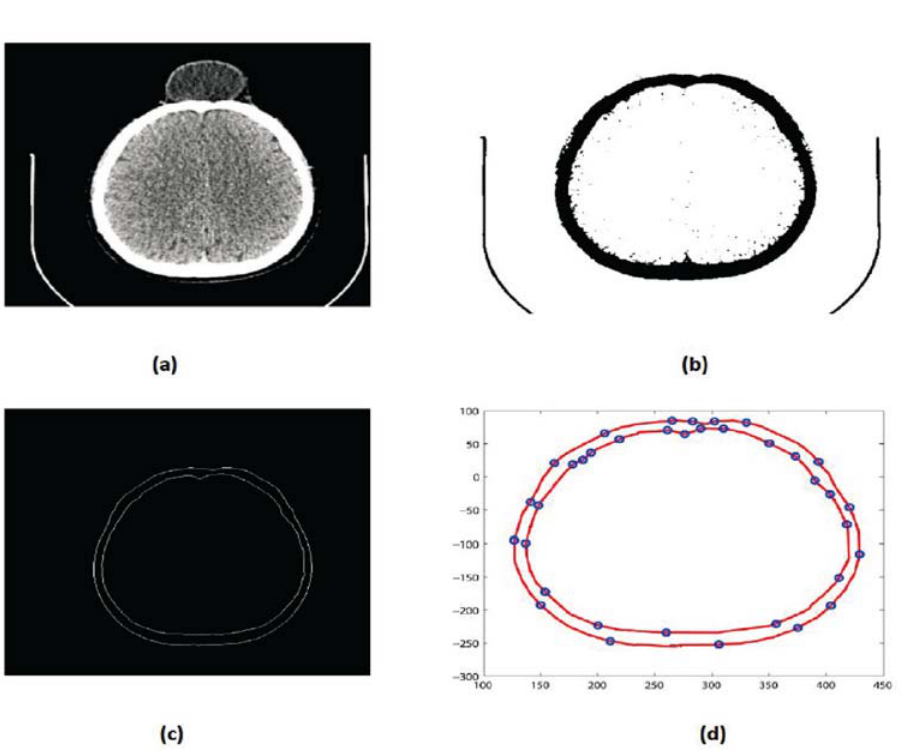
Fig 4. Reconstructed image of CT scan of Dicom slice 176. (a) Original image (b) Binary image (c) Boundary (d)Reconstructed boundary using rational cubic Ball